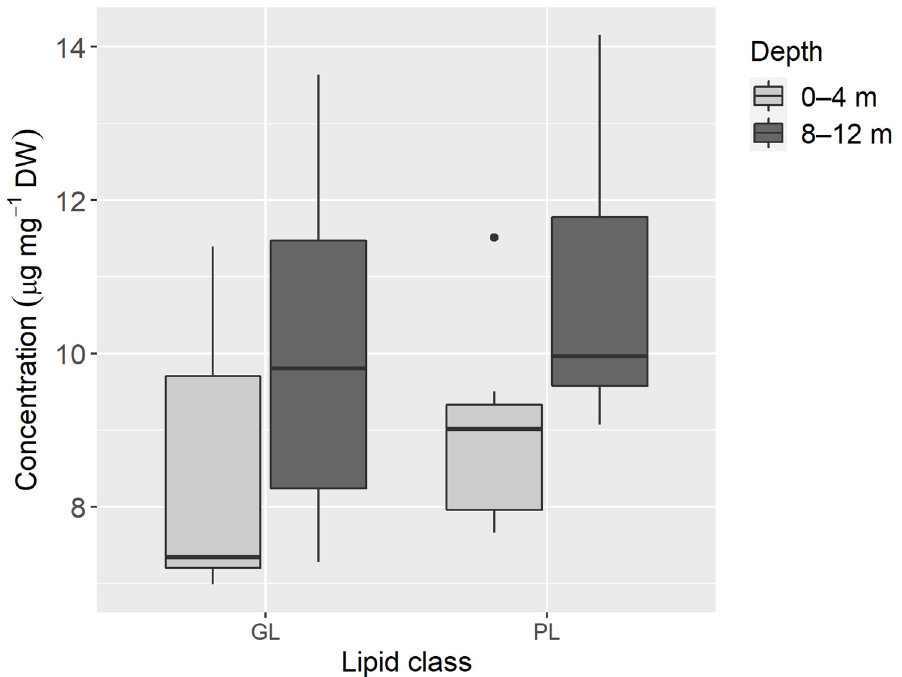
Figure 5. Glycolipid (GL) and phospholipid (PL) concentrations from samples of Elysia crispata collected at 0–4 m ( n = 7) and 8–12 m ( n = 7) depths, in the Southern Gulf of Mexico. The line represents the median, top and bottom of the box are the 25th and 75th percentiles. The whiskers represent the maximum and minimum values, and dots are outliers.